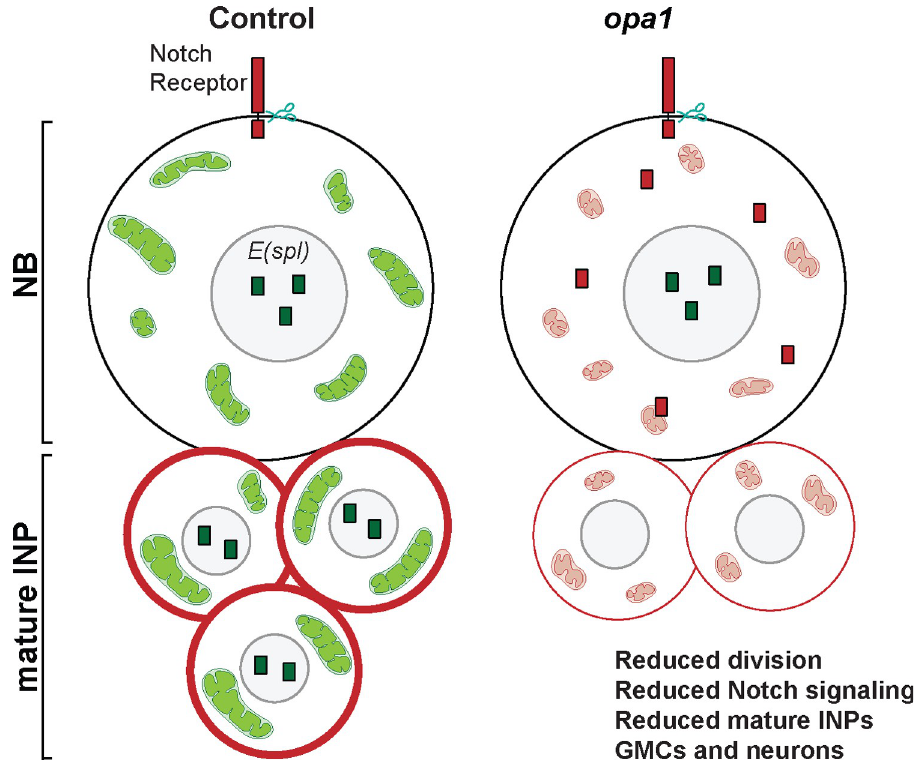
Fig 8. Schematic summary for regulation of type II NB differentiation by Opa1 driven fused mitochondrial morphology. Mitochondrial morphology is intermediate in state with some tubular mitochondria in the type II NBs. Notch receptor (red) is present on the plasma membrane in lineage cells and Notch signaling as seen by E(spl)m γ - GFP (green) is active in type II NBs and mature INPs. Loss of mitochondrial fusion by depletion of Opa1 leads to mitochondrial fragmentation in type II NBs and mature INPs, cytoplasmic accumulation of Notch receptor (red) in type II NBs and mature INPs while it is reduced from the membrane of mature INP cells leading to decrease in INP